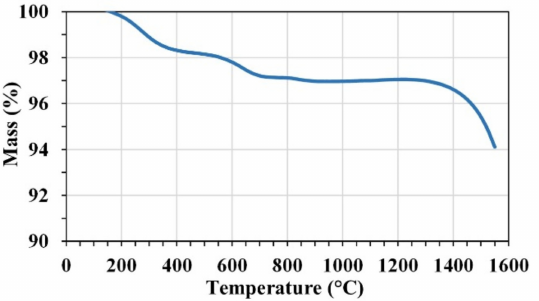
Figure 4. TGA analysis of raw scale used in the present